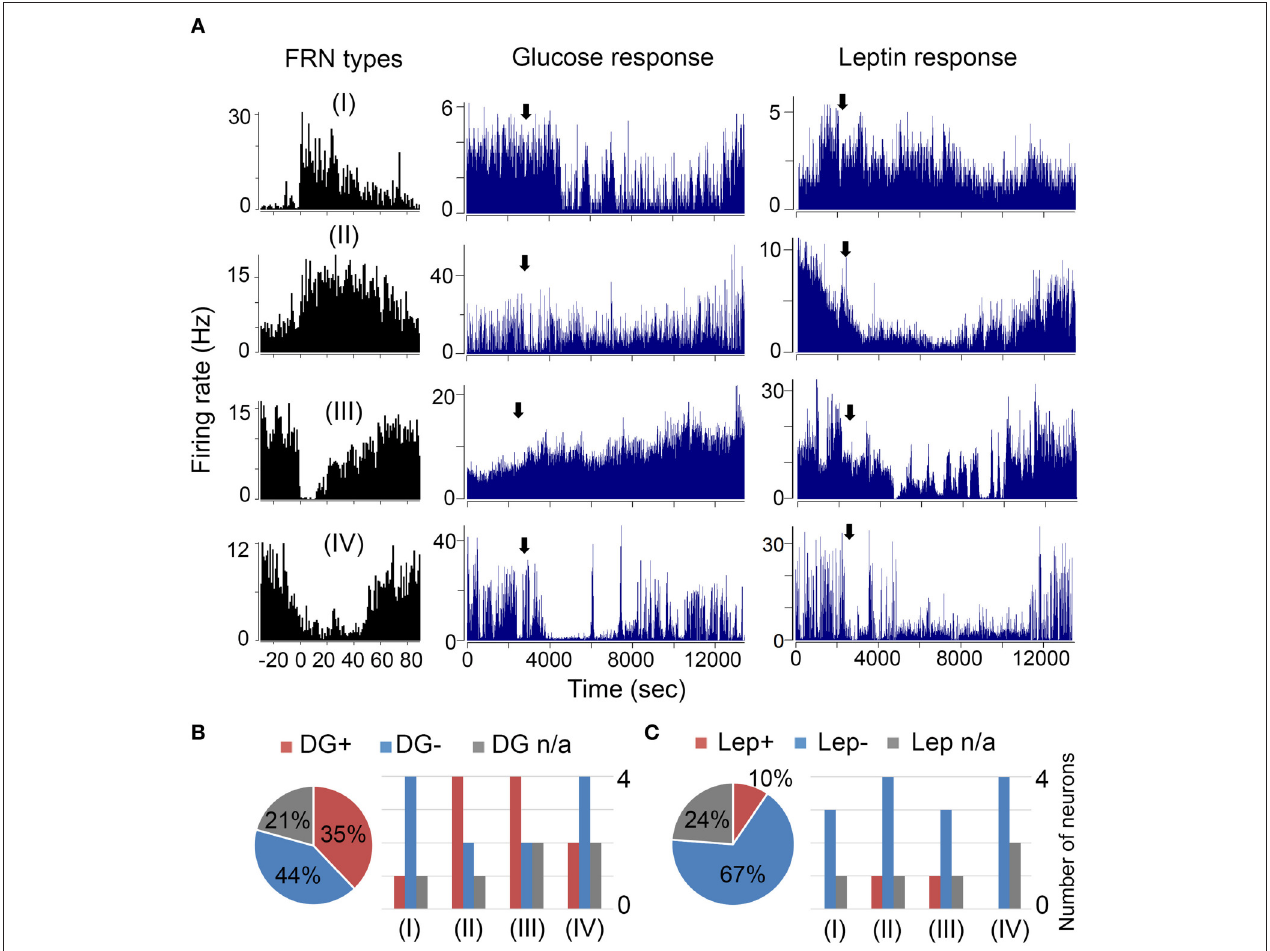
FIGURE 5 | Effects of glucose and leptin on FRNs. (A) Four examples of each type FRNs respond to glucose and leptin. In first line type I FRN’s spike rate decreased after glucose and leptin i.p. delivery. In second line type II FRN’s spike rate increased after glucose delivery but decreased after leptin i.p. delivery. In third line type III FRN’s firing rate decreased after glucose i.p. delivery but increased after leptin i.p. delivery. In fourth line type IV FRN’s firing rate decreased both after glucose and leptin i.p. delivery. (B) Left panel was the ratio of all FRNs’ response to glucose ( n = 29 neurons, N = 8 mice), right panel is statistical results of each type FRNs’ response to glucose. Similarly, the statistics of FRNs’ response to leptin were showed in left panel (C) was the ratio of all FRNs’ response to leptin ( n = 21 neurons, N = 8 mice) while the right panel was statistical results of each type FRNs respond to